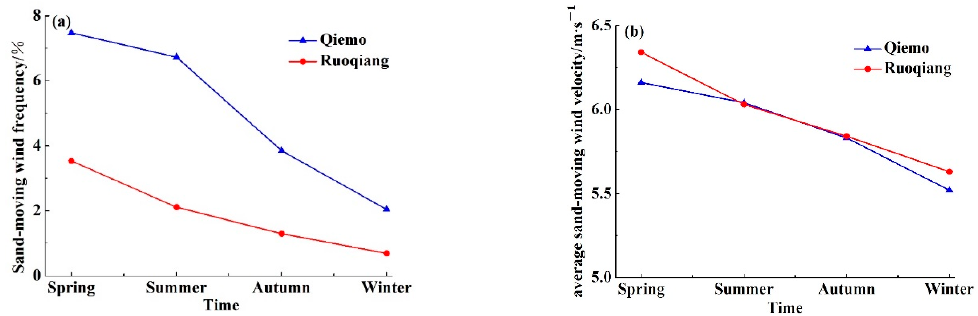
Figure 4. Seasonal sand-moving wind frequency and velocity: ( a ) sand-moving wind frequency; ( b ) average sand-moving wind velocity.